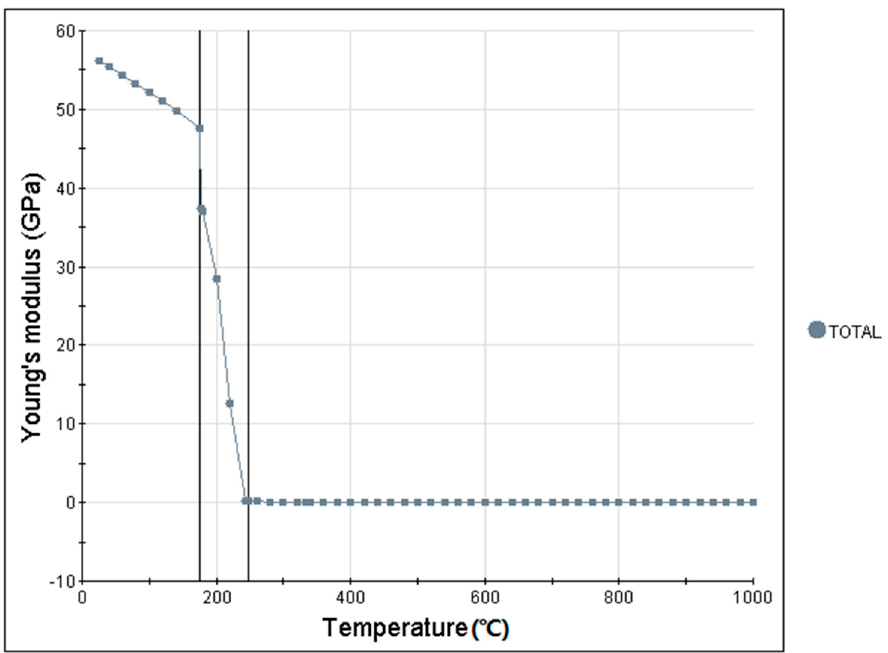
Figure 5. Result of analysis of solidification phases and properties: Young’s modulus (GPa)–temperature °C.